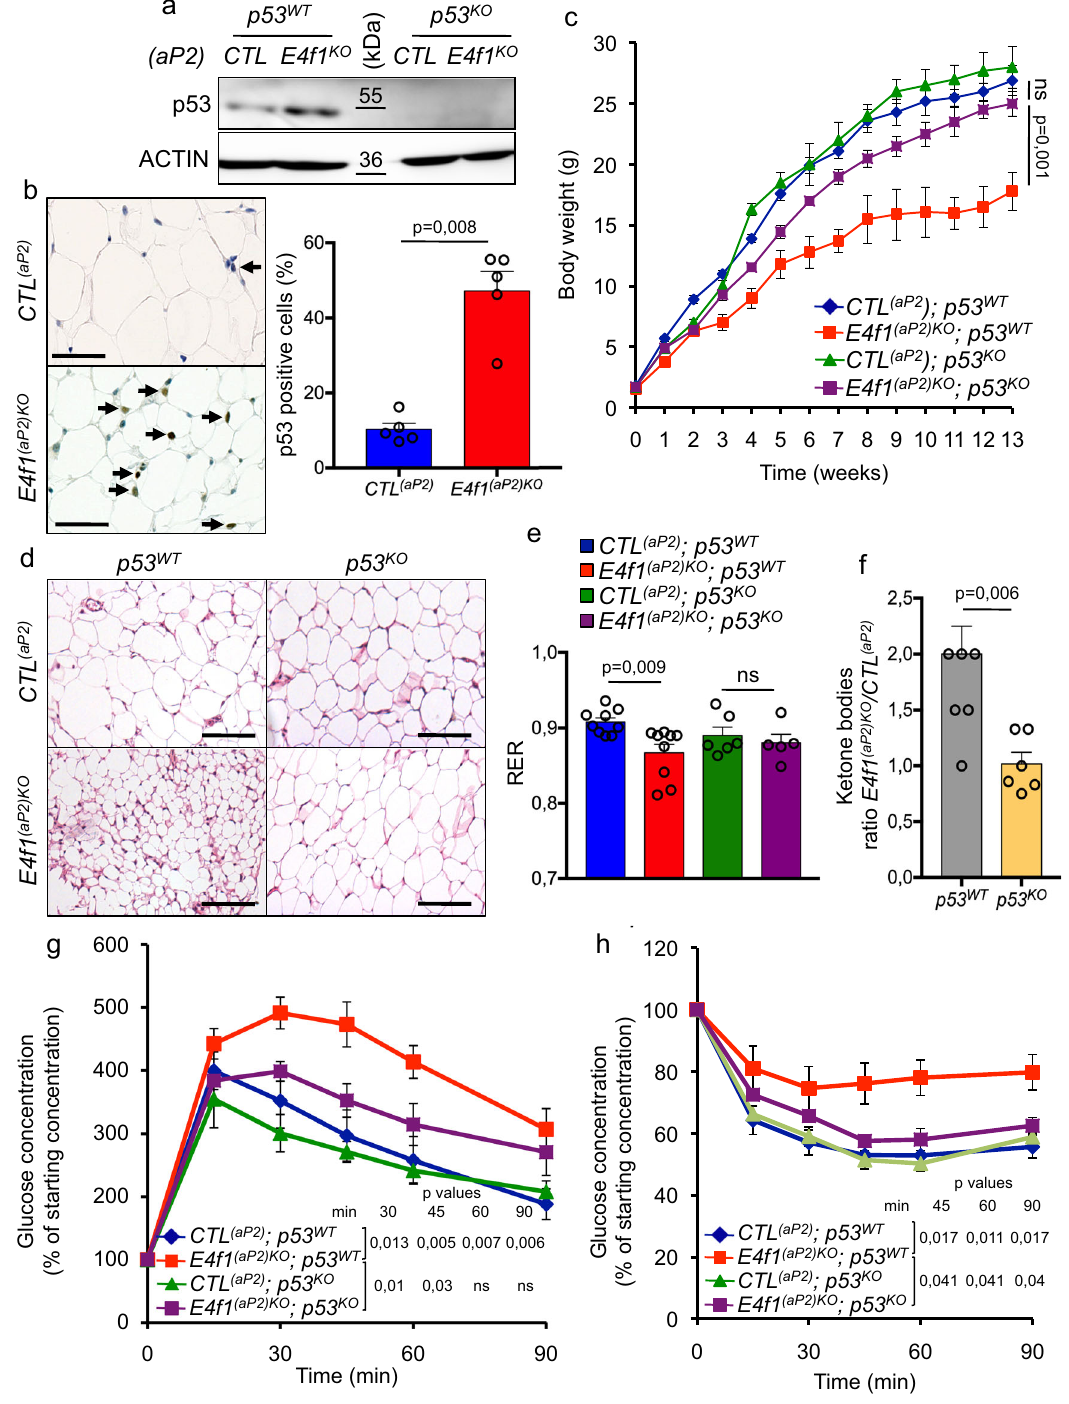
detailed analysis of PL in E4f1 cKO and control adipocytes, 10 days after induction of differentiation, using a semi-quantitative lipidomic electrospray ionization tandem mass spectrometry (ESI-MS-MS) approach. These analyses revealed a signi fi cant shift in the composition of PL in E4f1 cKO cells with a decrease in the relative amounts of monounsaturated PL species relying on SCD1 activity (C16:1, C30:1, C32:1, C32:2). This effect was the strongest for phosphatidylcholine (PC) species (Fig. 7d), inter- mediate for phosphatidylethanolamine and phosphatidylinositol, and less pronounced for phosphatidylserine (Supplementary Fig. NATURE COMMUNICATIONS| (2021) 12:7037